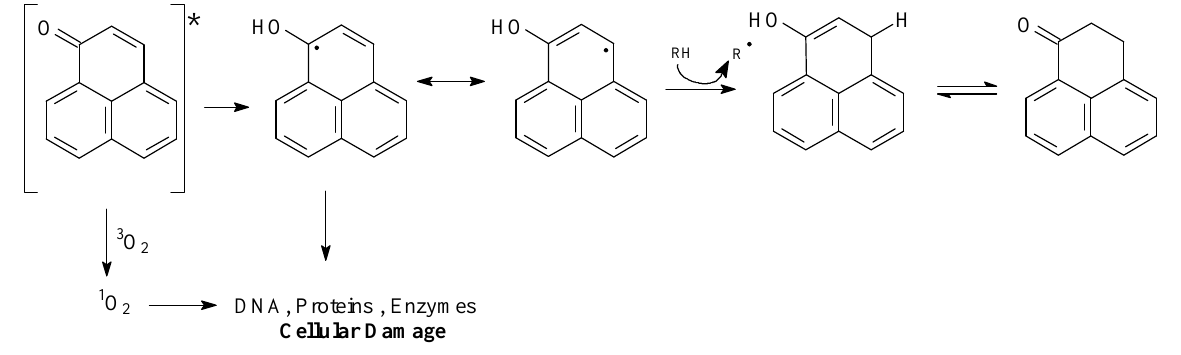
Figure 4. Singlet oxygen and biological effects by